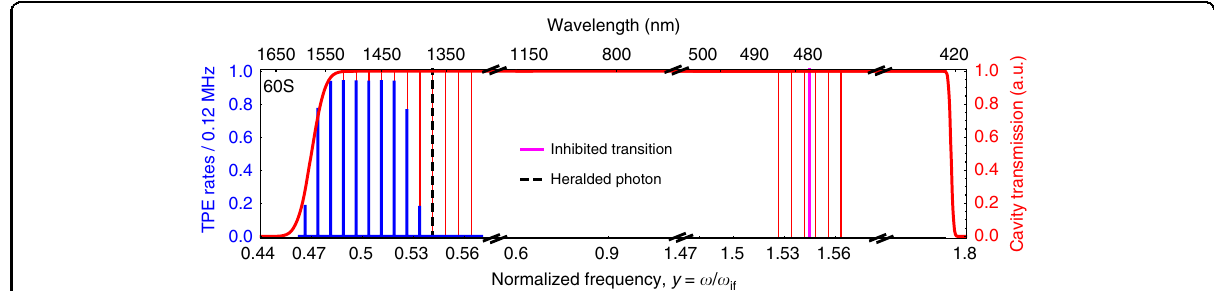
Fig. 3 Enhancement of the two-photon emission rates (TPE) for a Rydberg atom (60S1/2 → 6S1/2) inside a cavity. Enhancement of the two- photon emission rates (TPE) for a Rydberg atom (60S 1/2 → 6S 1/2 ) inside a cavity. Cavity-enhanced TPE generates an entangled photon comb (blue); the TPE enhancement at each frequency depends both on the cavity Purcell factor at this frequency and on the Purcell factor at the frequency of the other photon in the pair. The cavity length is tuned such that the heralding transition at 1366.87 nm (black dashed) is enhanced by the cavity while all the other one-photon decay transitions are inhibited by being off-resonant. In particular, the fastest one-photon process 60S 1/2 → 5P 3/2 at 479.79nm is also inhibited by the cavity (magenta). The envelope of the cavity transmission spectrum is shown in